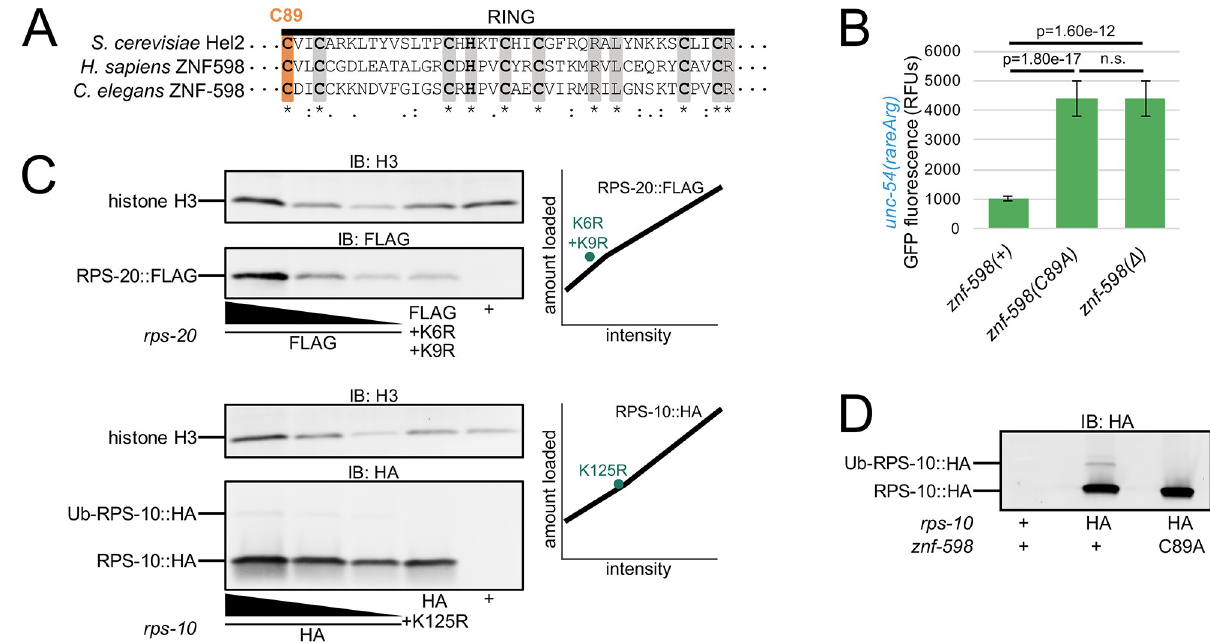
Fig 3. ZNF-598 is required for ribosomal ubiquitination in C . elegans . (A) Multiple sequence alignment of S . cerevisiae Hel2, H . sapiens ZNF598, and C . elegans ZNF-598 RING finger domains. Conserved residues (gray) and C89 (orange) are highlighted. Conservation below alignment is as follows: asterisks indicate identity, colons indicate amino acids with strongly similar properties, periods indicate amino acids with weakly similar properties. (B) Mean RFUs (relative fluorescence units) of indicated strains (n � 15 animals/strain) in the unc-54(rareArg) background. One standard deviation shown as error bars. p values from Welch’s t-test. (C) Western blot of indicated strains to monitor RPS-20 and RPS-10 expression. Dilutions of wild type tagged proteins were loaded as indicated, with two-fold more and two-fold less than other two samples, to generate a standard curve shown as a black line in plots on the right. Lysine mutants of tagged proteins were quantified and plotted as teal points in the plots on the right. (D) Western blot of indicated strains to monitor ubiquitination of HA-tagged RPS-10.